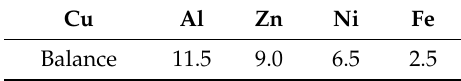
Table 1. Chemical composition of the experimental alloy (wt